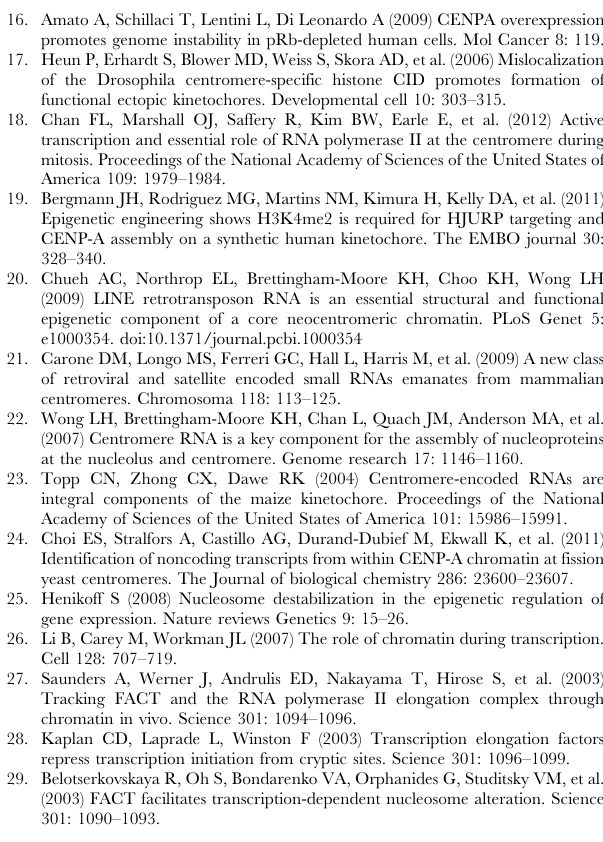
Table S1 Relative enrichment of CENP-A Cnp1 and H3 in spt16- 18 versus wild-type cells (at 36 u C) at selected genes from ChIP- chip data and their relative RNA expression levels (at 30 u C; transcription levels were categorized as in Figure